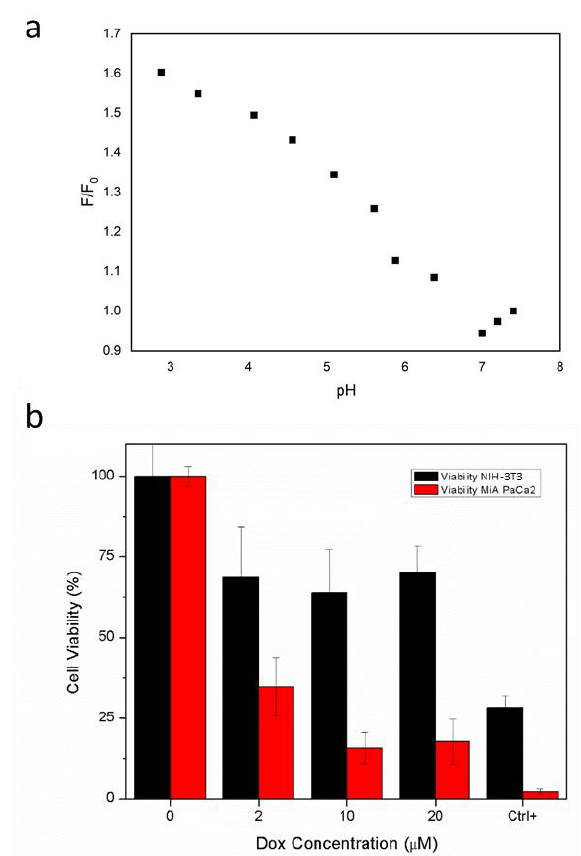
Figure 3. ( a ) Release of doxorubicin (Dox) from Apt-Dendr-NP in medium at different pH; ( b ) Cell viability after treatment with Apt-Dendr-NP.